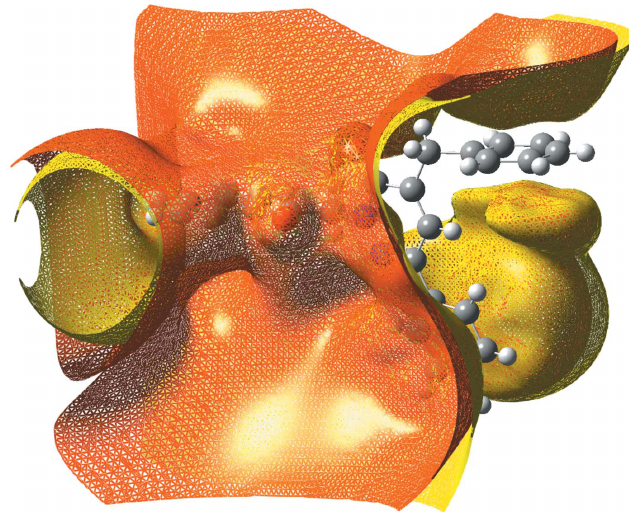
Figure 5 Total electron density mapped over the molecular electrostatic potential surface of the title